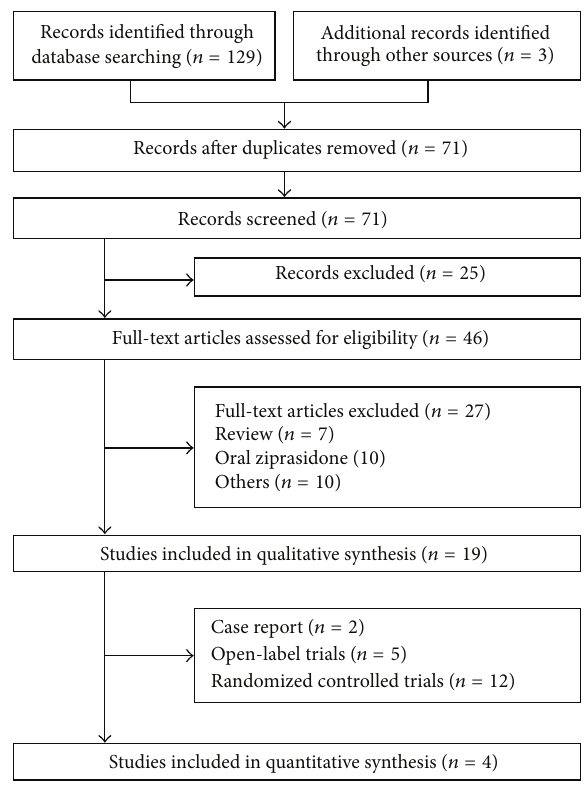
Figure 1: PRISMA flow